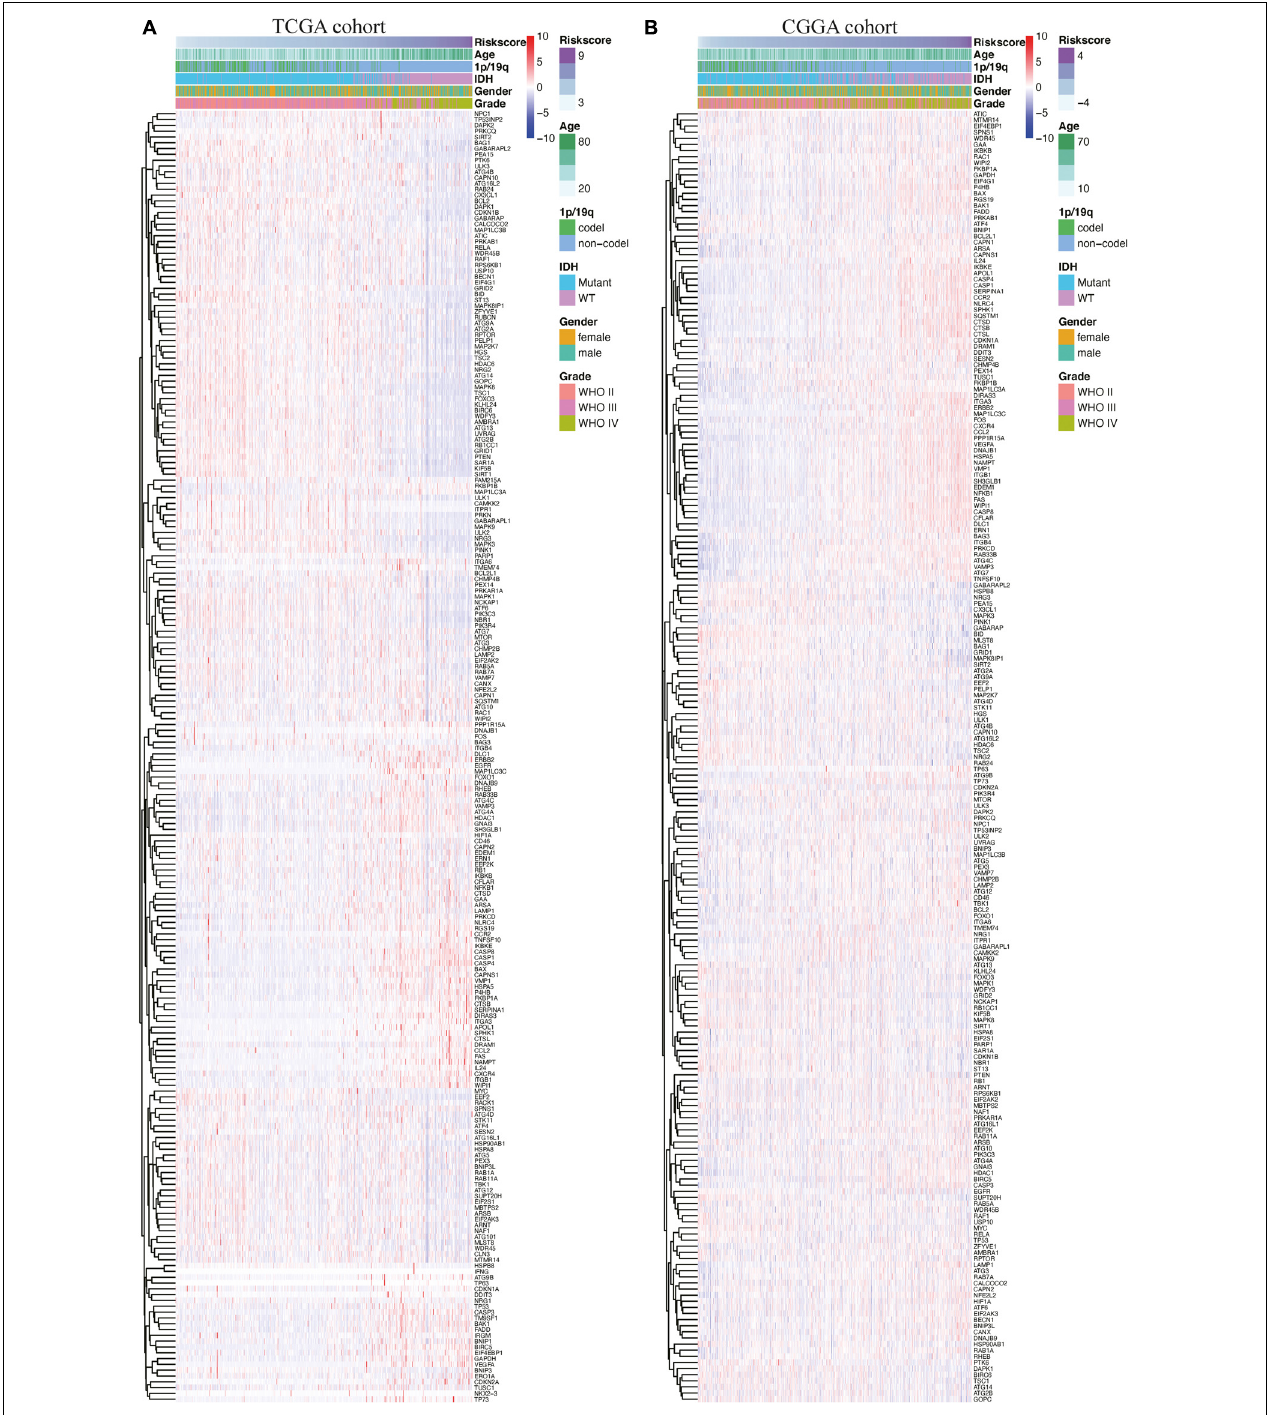
FIGURE 3 | Heatmaps of autophagy-related genes based on the risk score value in The Cancer Genome Atlas (TCGA) cohort (A) and the Chinese Glioma Genome Atlas Chinese Glioma Genome Atlas (CGGA) cohort (B) .